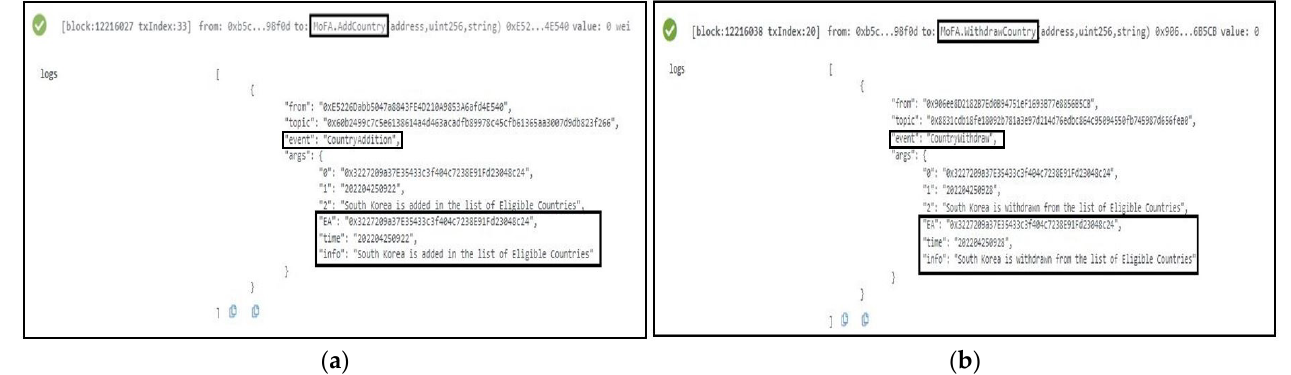
Figure 6. Deployment of MoFA Smart Contract. In ( a ), the AddCountry function is successfully deployed with Country’s EA, time, and info. In ( b ), Withdrawal of country is performed successfully by the WithdrawCountry function.